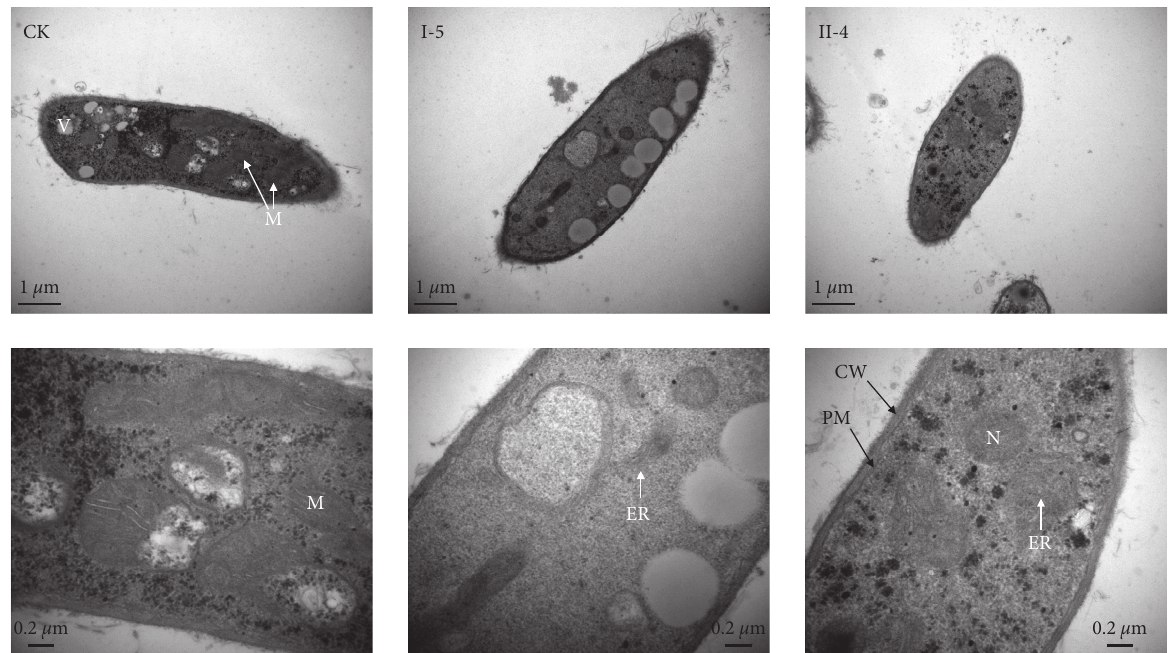
Figure 6: TEM investigation of Physalospora piricola hyphae treated with I-5 and II-4. CW: cell wall; PM: plasma membrane; N: nucleus; V: vacuole; M: mitochondria; ER: endoplasmic